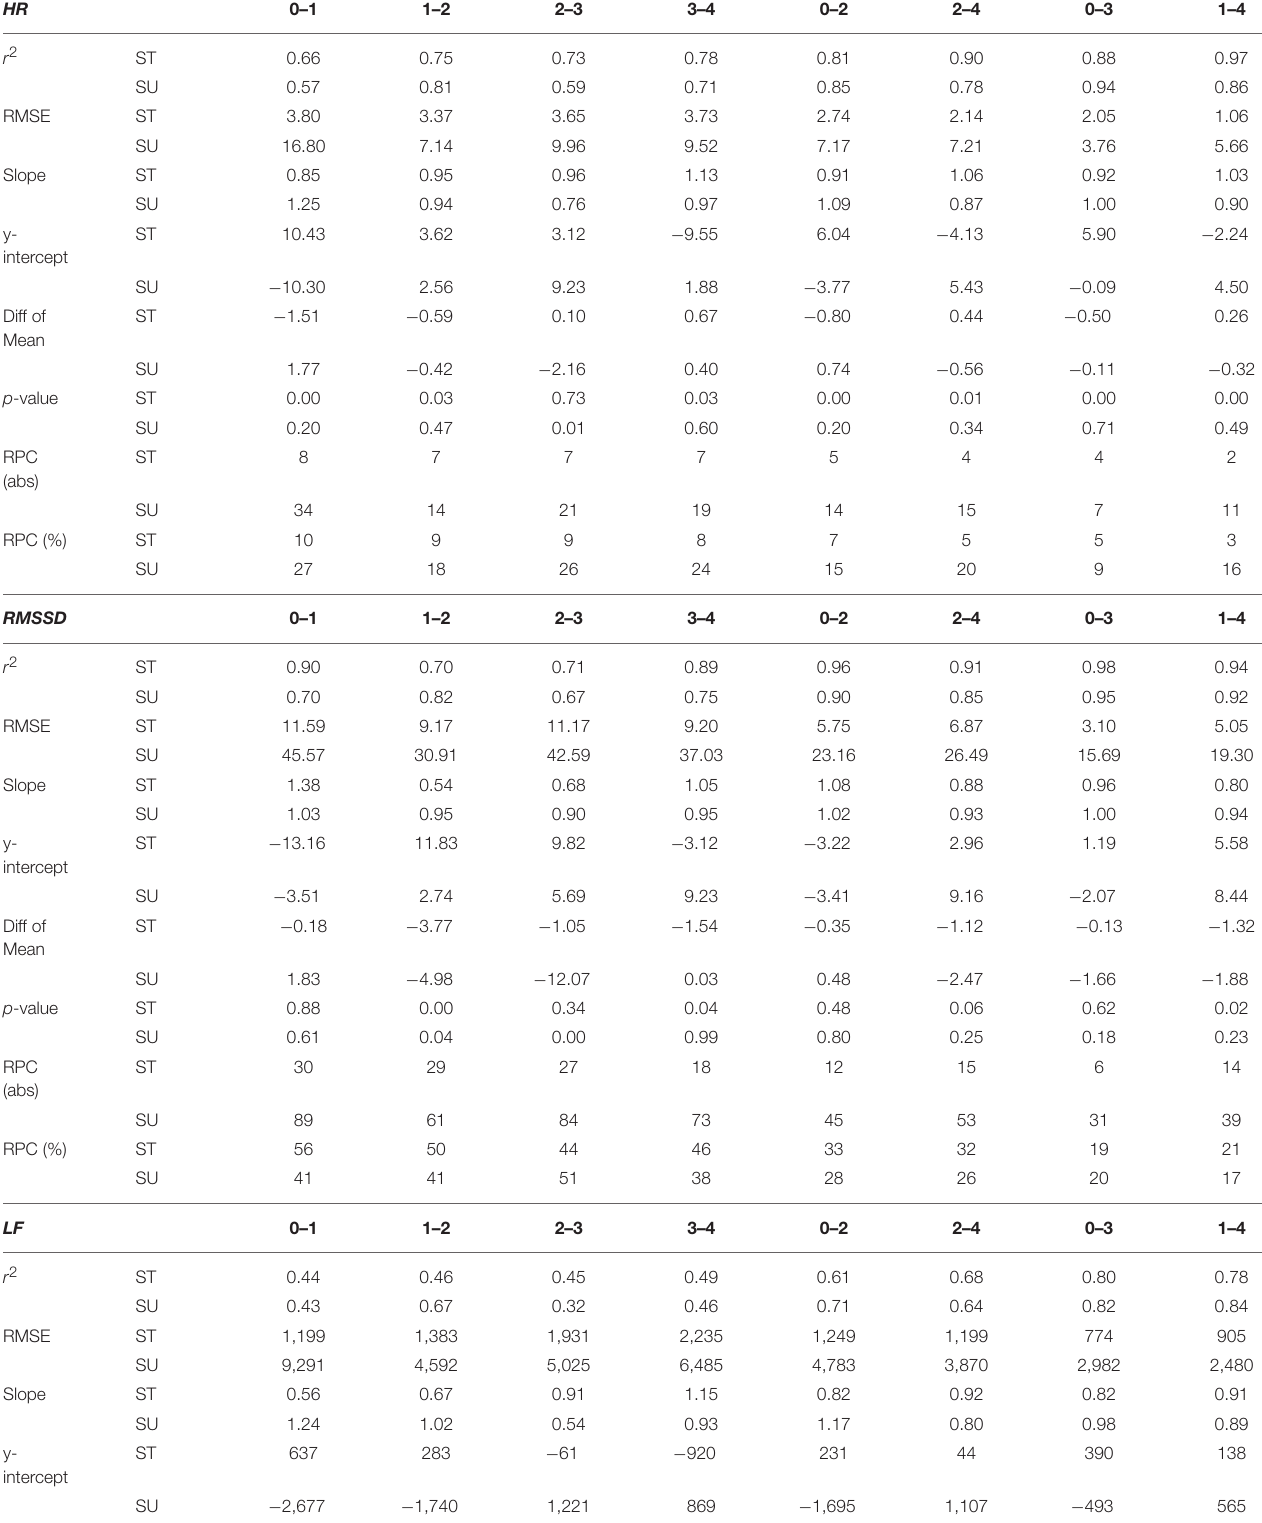
TABLE 1 | Systematic correlation and Bland and Altman data for all windows comparison to the reference 0–4